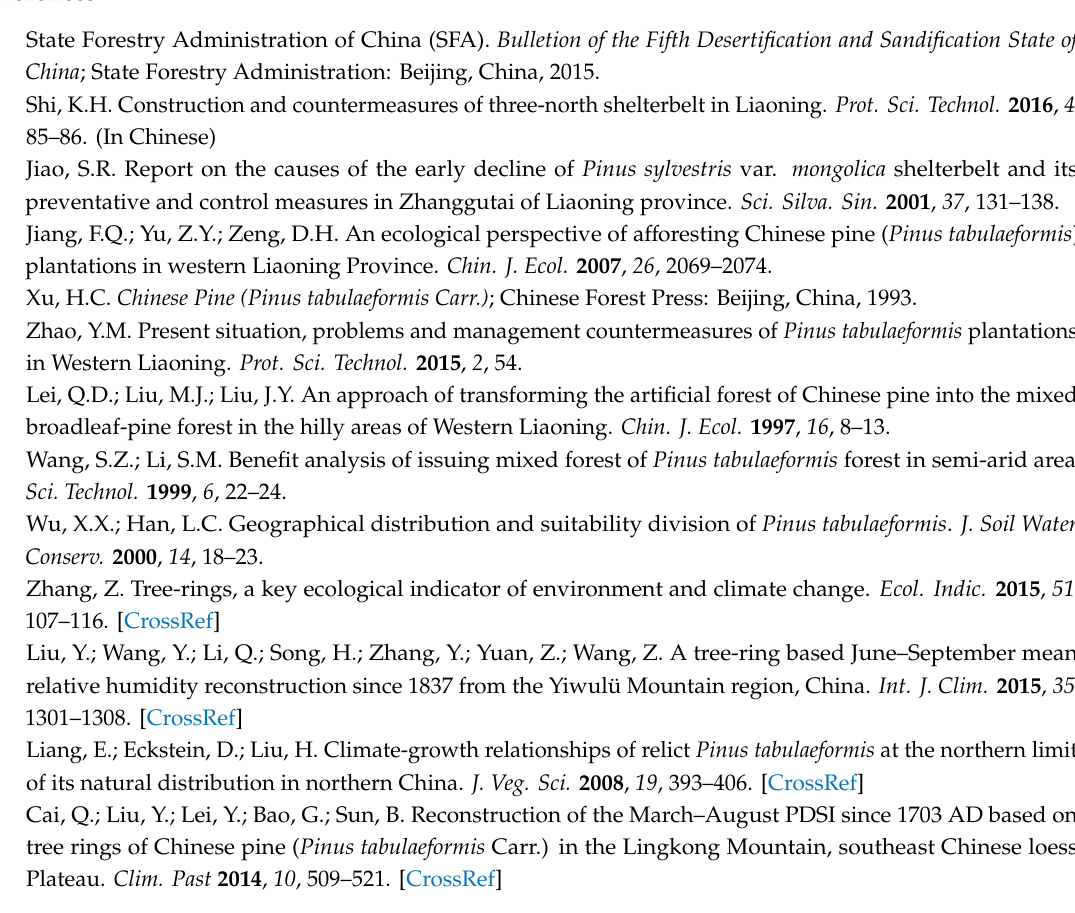
Table S1: Correlations between the tree-ring width chronologies of WFY and scPDSI on seasonal scale during 1951–2014 (note that all correlation coe ffi cients (R) at p < 0.01; P indicates previous year, C indicates current